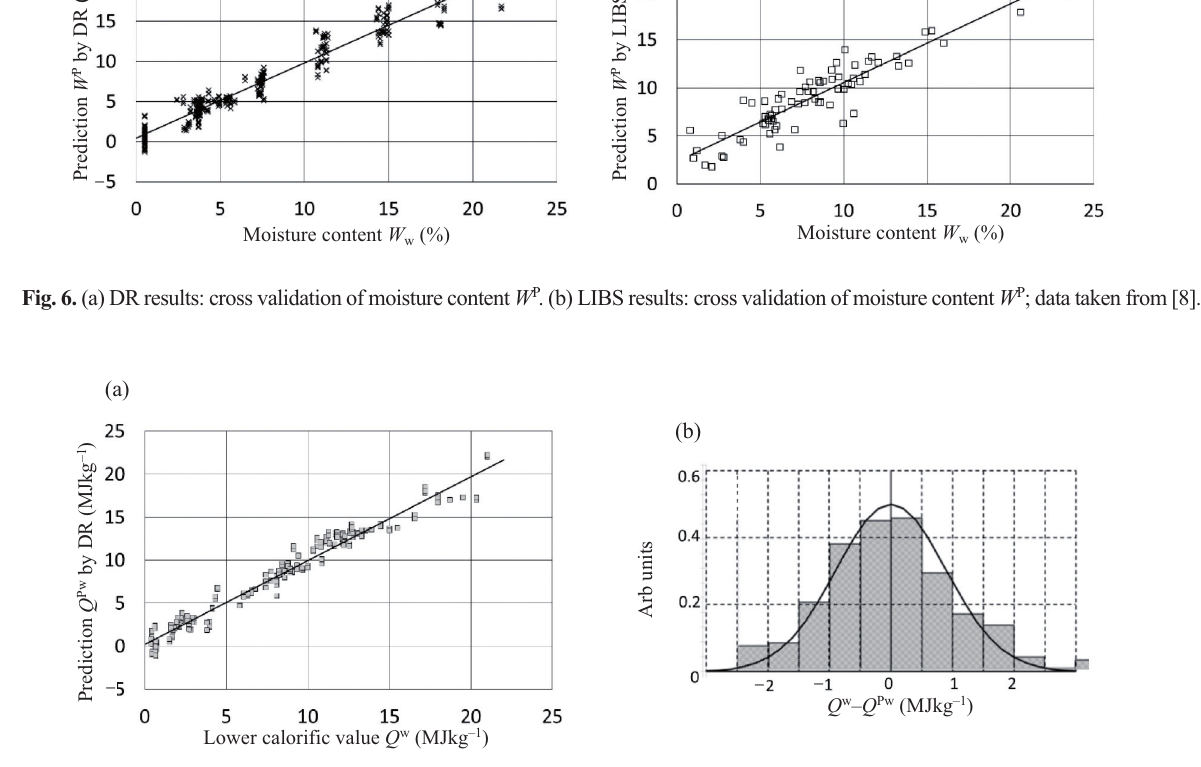
Fig. 7. DR results: (a) cross validation of lower calorific value; (b) histogram corresponding to prediction of lower calorific value; solid line – Gaussian fit characterized by standard deviation 1 MJkg –1